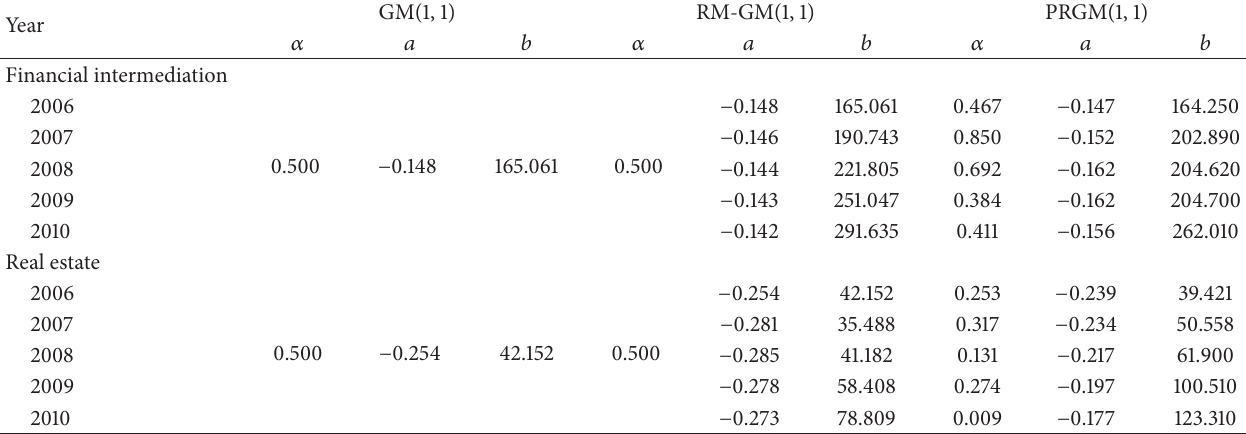
Table 2: The parameter values calculated by GM(1, 1), RM-GM(1, 1), and PRGM(1, 1), respectively.